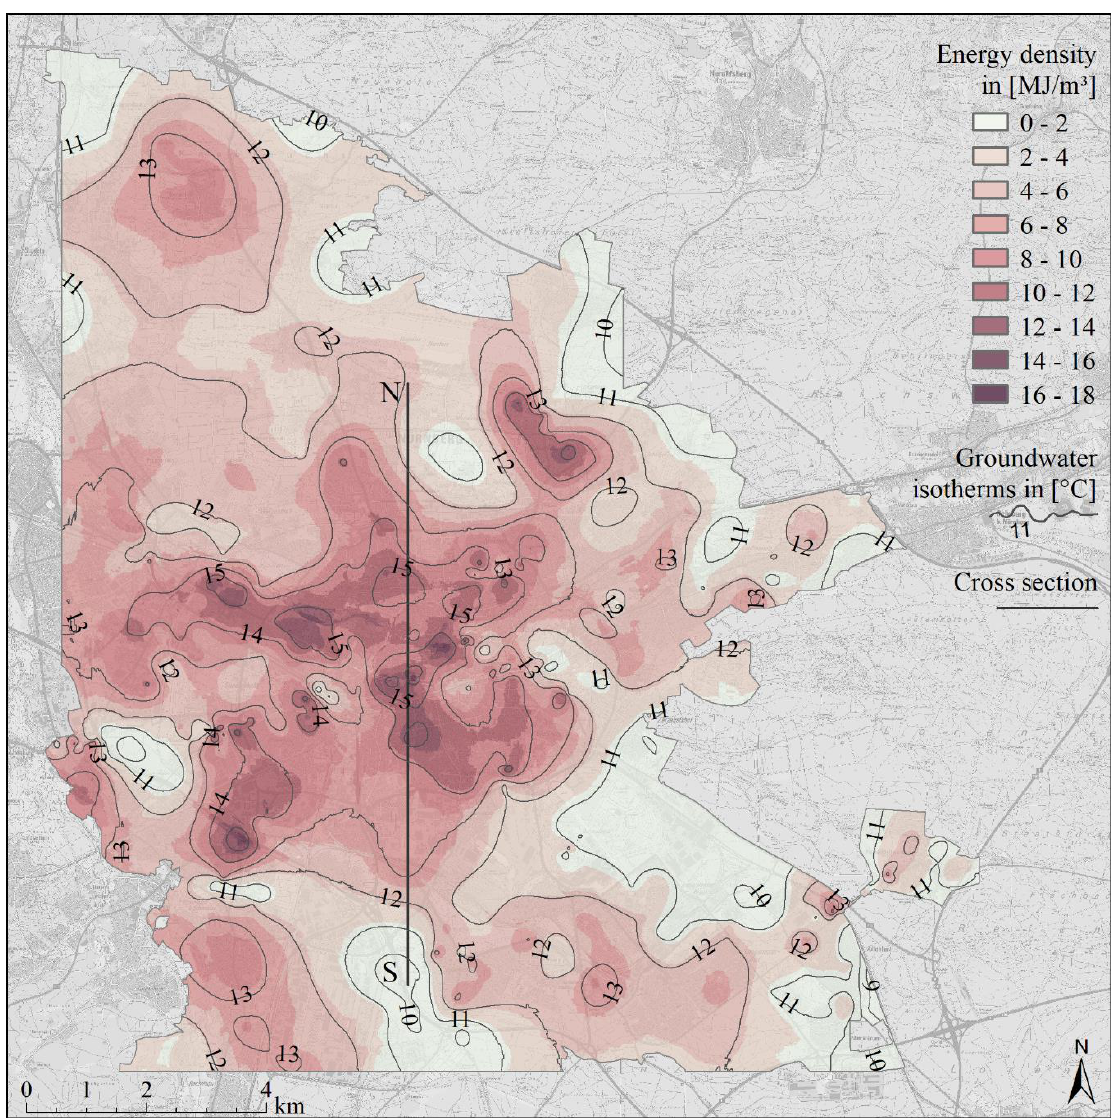
Figure 6. Spatial distribution of the energy density and suburban heat island of the city of Nuremberg. Topographic basemap, TK 1:25 000, ATKIS ® , DLM1000; Copyright © Bundesamt für Kartographie und Geodäsie, 2008.